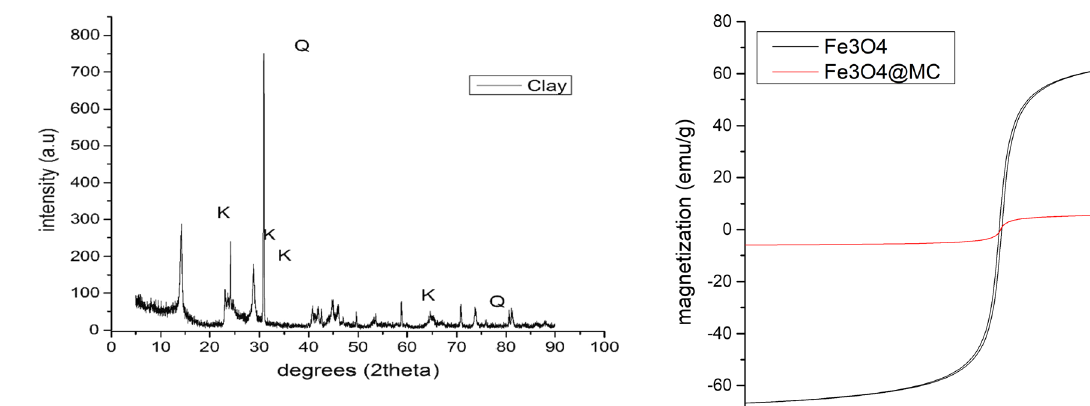
Fig. 1 XRD pattern for clay